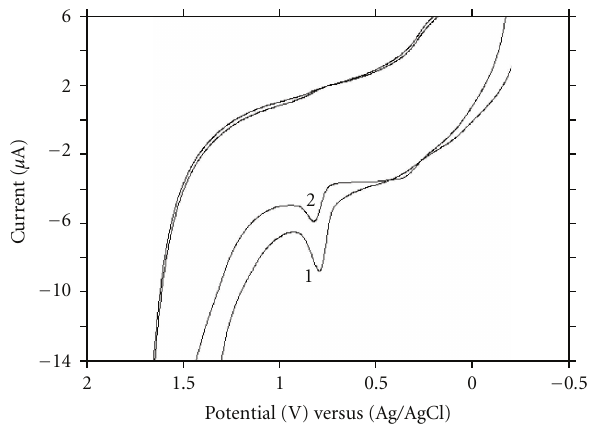
Figure 1: (1) First cycle and (2) second cycle of the repetitive voltammograms for 8 × 10 − 5 M fulvestrant solution in 0.1 M sulphuric acid solution. Curves are from 0 to +1.8V. Scan rate is